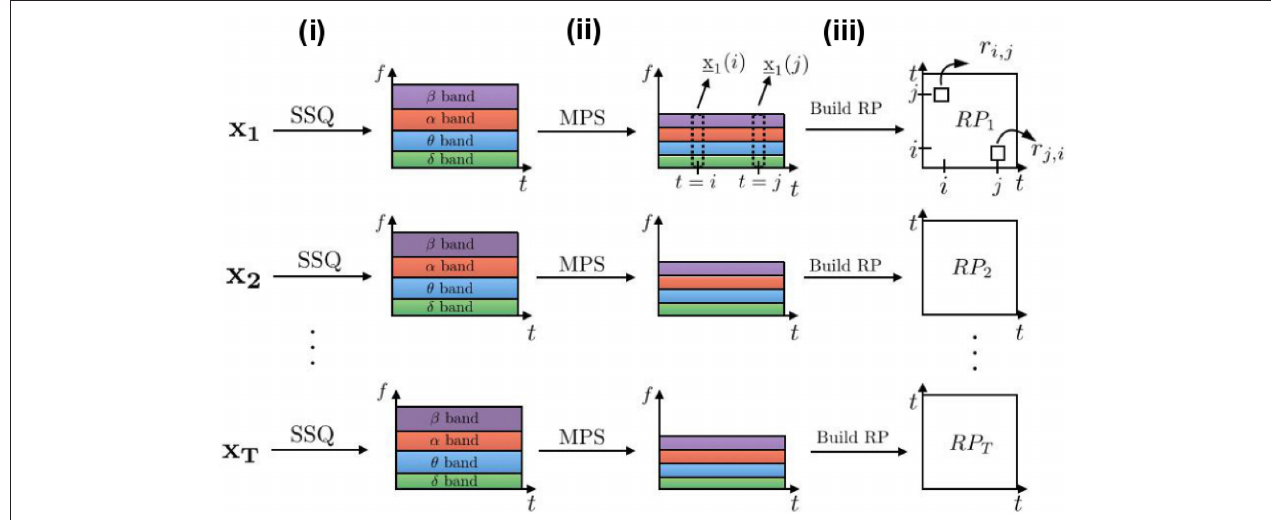
FIGURE 1 | Building frequency-selective recurrence plots from T time series. Processing blocks are represented by arrows: (i) SSQ is a synchrosqueezing transform block used to obtain time-frequency representations of signals; (ii) the MPS block computes mean values of the power spectrum for each of the chosen frequency bands, which reduces the signal dimensionality; (iii) This signal is the basis for the recurrence analysis leading to recurrence plots